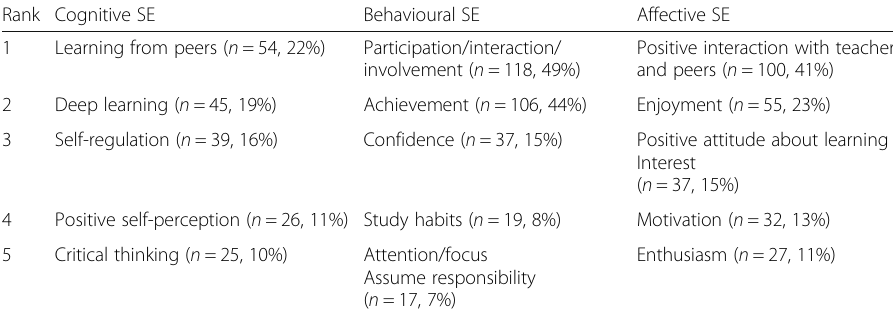
Table 3 Top 5 most often identified student engagement indicators according to student engagement dimension (Studies n =